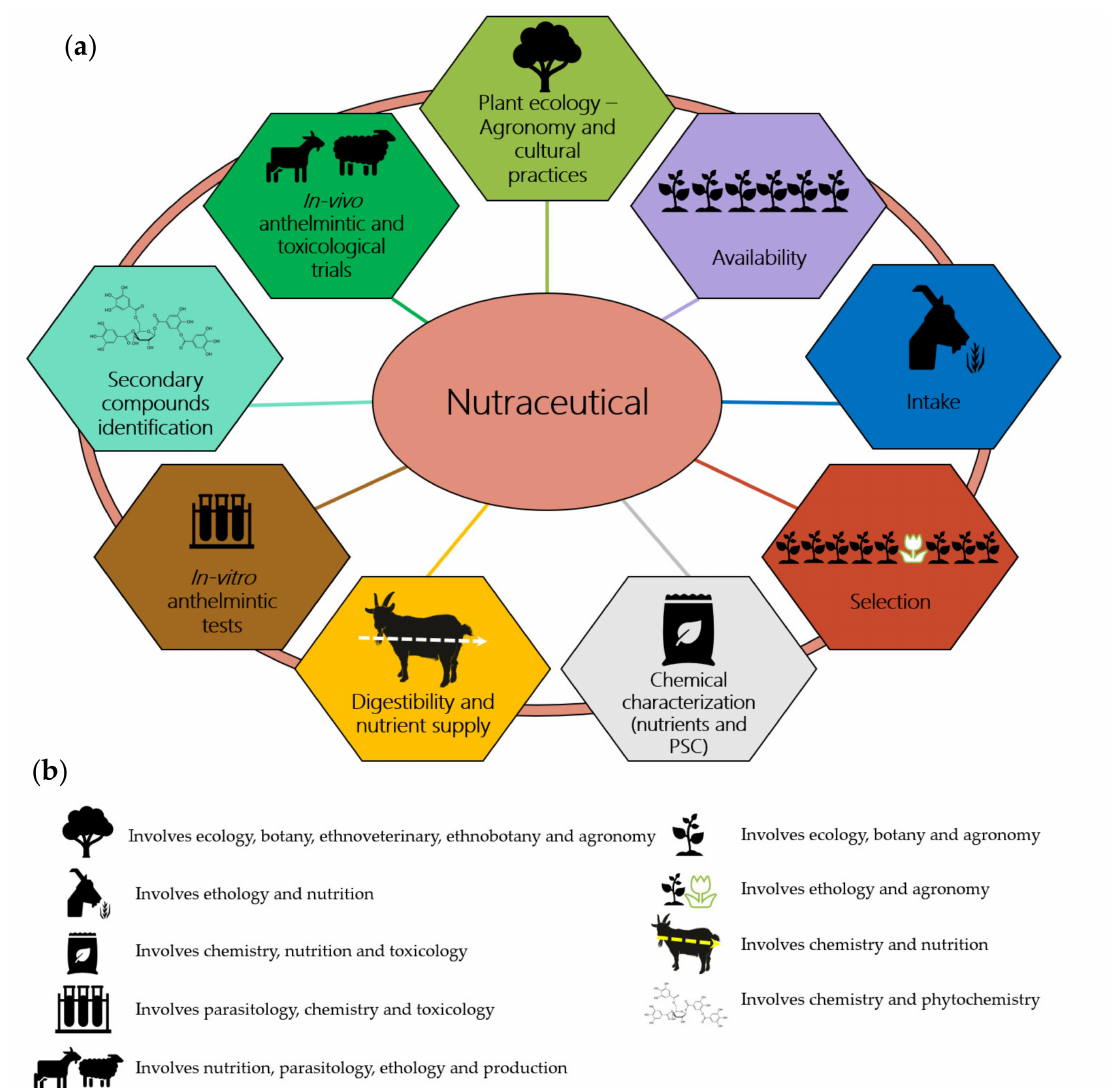
Figure 5. Proposed protocol for the identification of plants with nutraceutical potential. ( a ) For